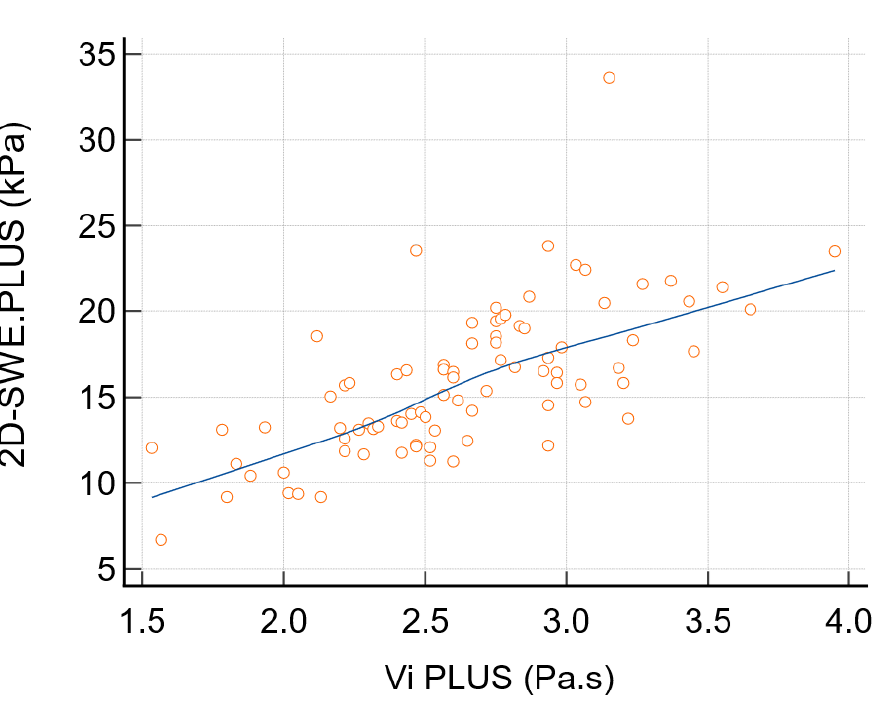
Figure 3. Correlation between the mean viscosity values and stiffness values of thyroid parenchyma in healthy volunteers (blue line — trend line).